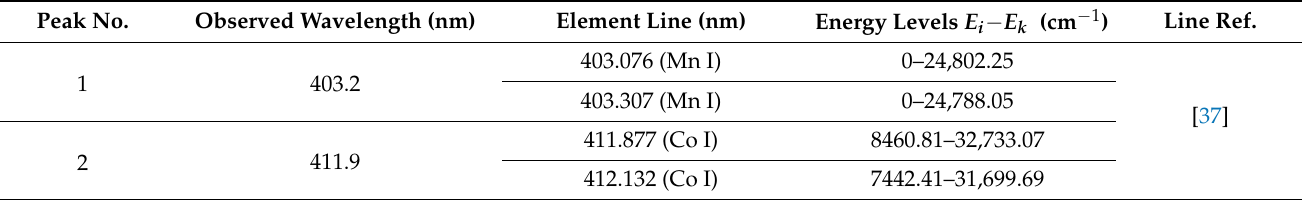
Table 3. Observed peaks as well as corresponding element lines including the corresponding energy levels. Data taken from [34]. Peak